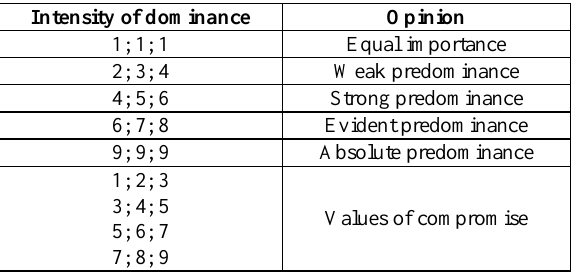
Figure 3. Saaty’s semantic scale